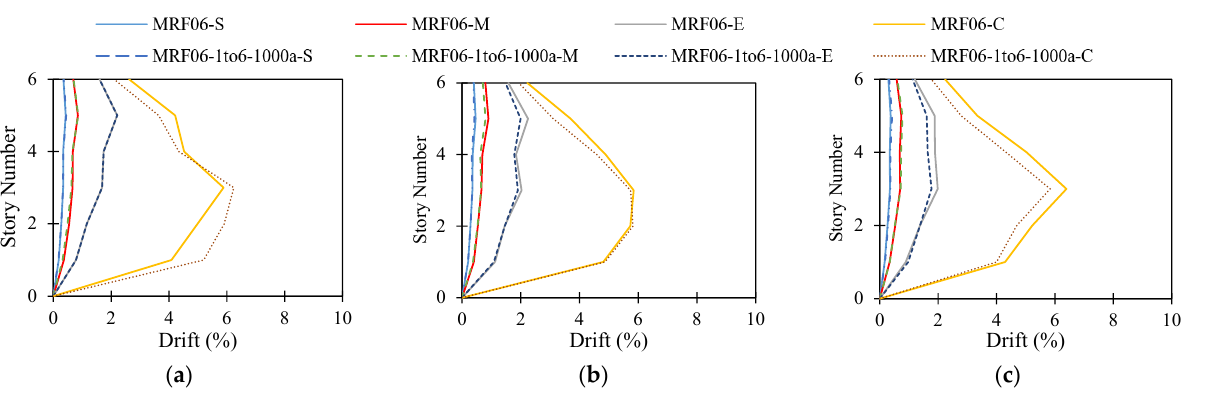
Figure 13. Inter-story drift ratios for 6-story structure subjected to ( a ) FF, ( b ) NF-No Pulse, and ( c ) NF-Pulse records, respectively.